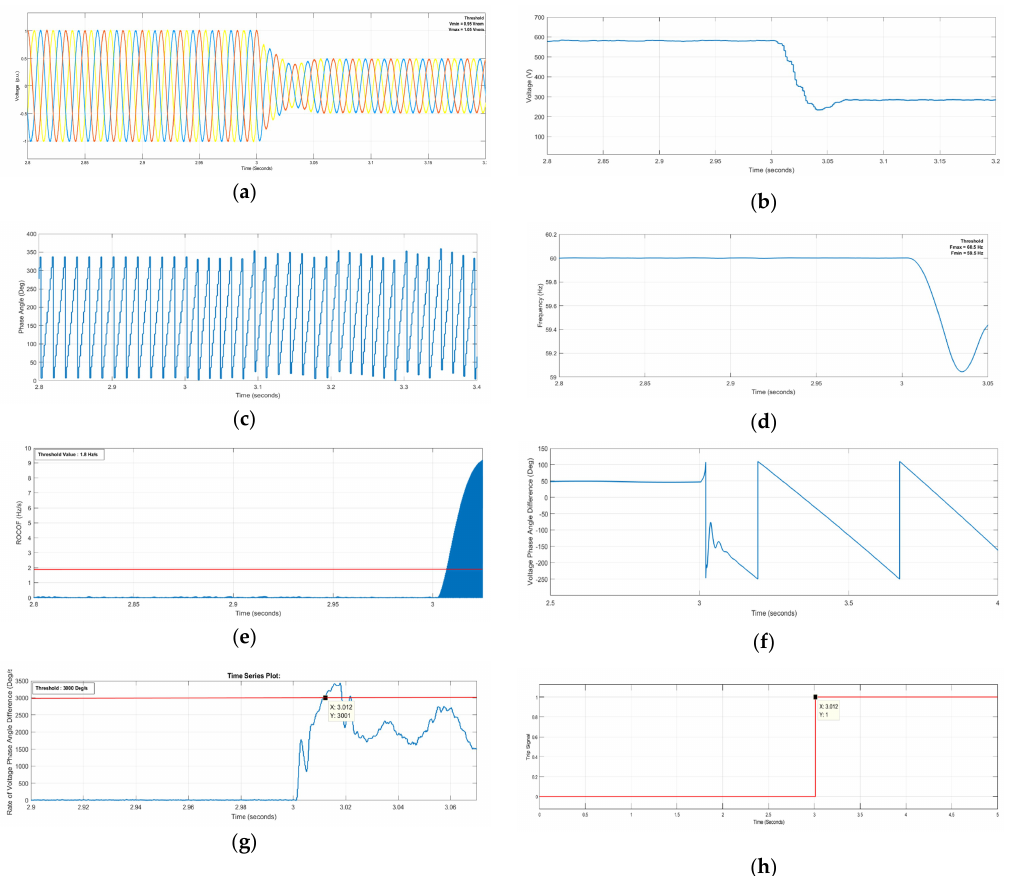
Figure 10. Results of case (ii) Islanding condition: power generated by DG < power requirement of local loads. ( a ) Feeder voltage; ( b ) DG voltage magnitude; ( c ) DG voltage phase angle; ( d ) frequency relay; ( e ) ROCOF relay; ( f ) Voltage phase angle difference; ( g ) Rate of change of voltage phase angle difference; ( h ) Trip Signal.